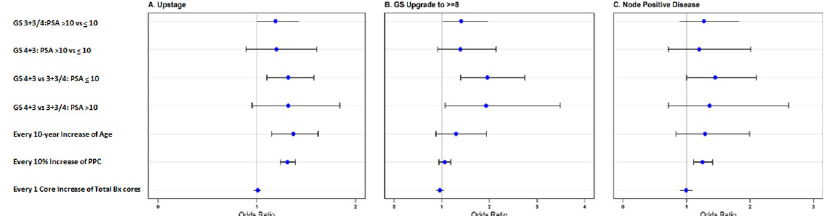
Fig 2. Multivariate analyses of factors predictive of pathological upstage, upgrade and node positive disease. Odds ratios (with 95% confidence intervals in S1 Table) of factors predictive of A) pathological upstage to pT3 or higher disease, B) pathological upgrade to GS 8 or higher, and C) pathological node positive disease. GS- Gleason Scores. Bx = biopsy. PPC = percent positive biopsy